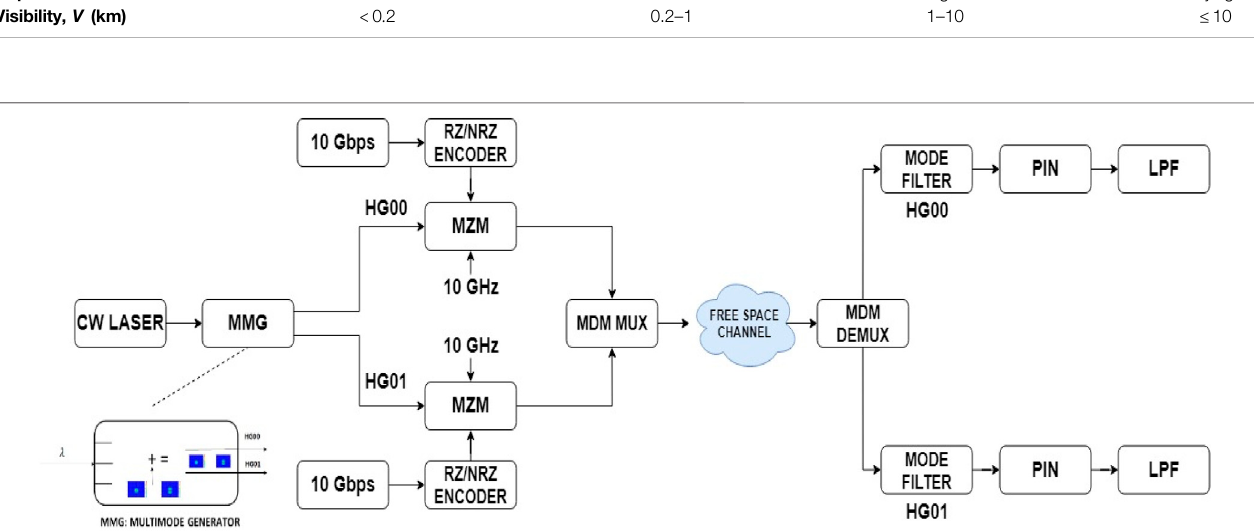
Frontiers in Physics |